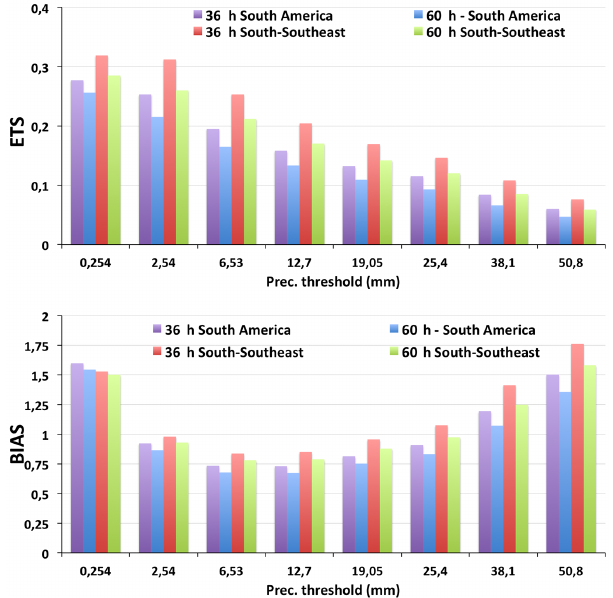
Figure 24. BRAMS 5km operational forecast over South America. Model performance evaluation with BIAS (upper panel) and RMSE of five near-surface quantities: 2m temperature and dew-point tem- perature (K), 10m wind speed (ma − 1 ) , 24h accumulated precipi- tation (mm) and the mean sea level pressure (hPa).